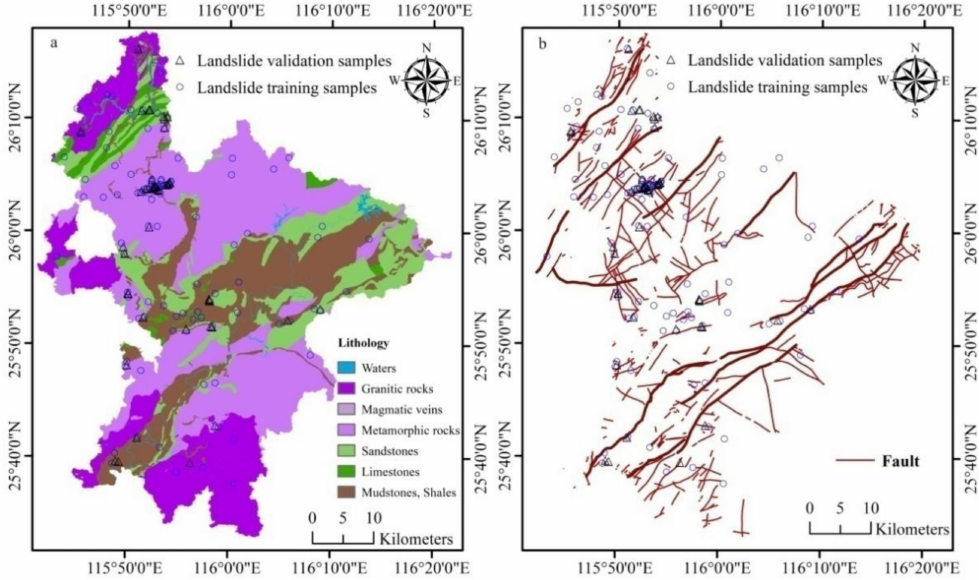
Figure 4. Geo-environmental factors 2: ( a ) lithology and ( b ) faults.